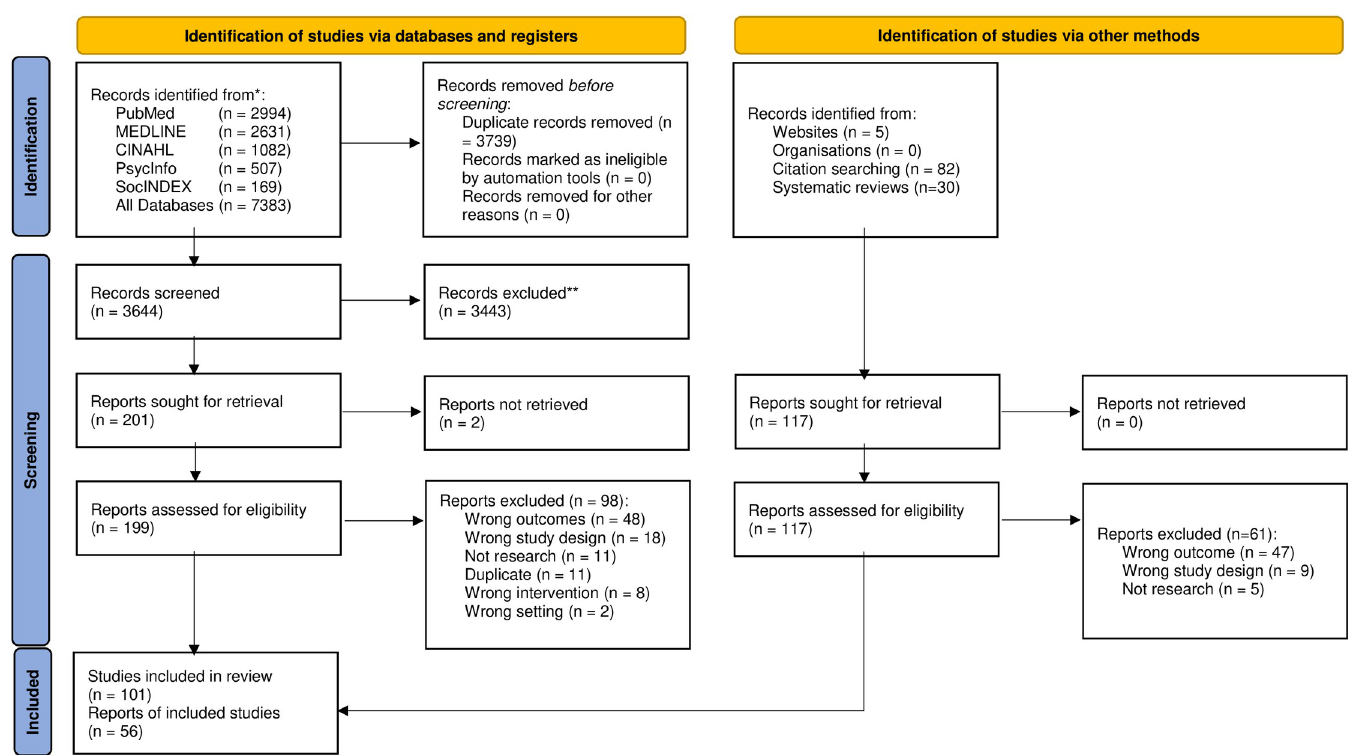
Fig 1. PRISMA 2020 flow diagram: Determinants of regulatory compliance in health and social care services: A systematic review using the consolidated framework for implementation research.